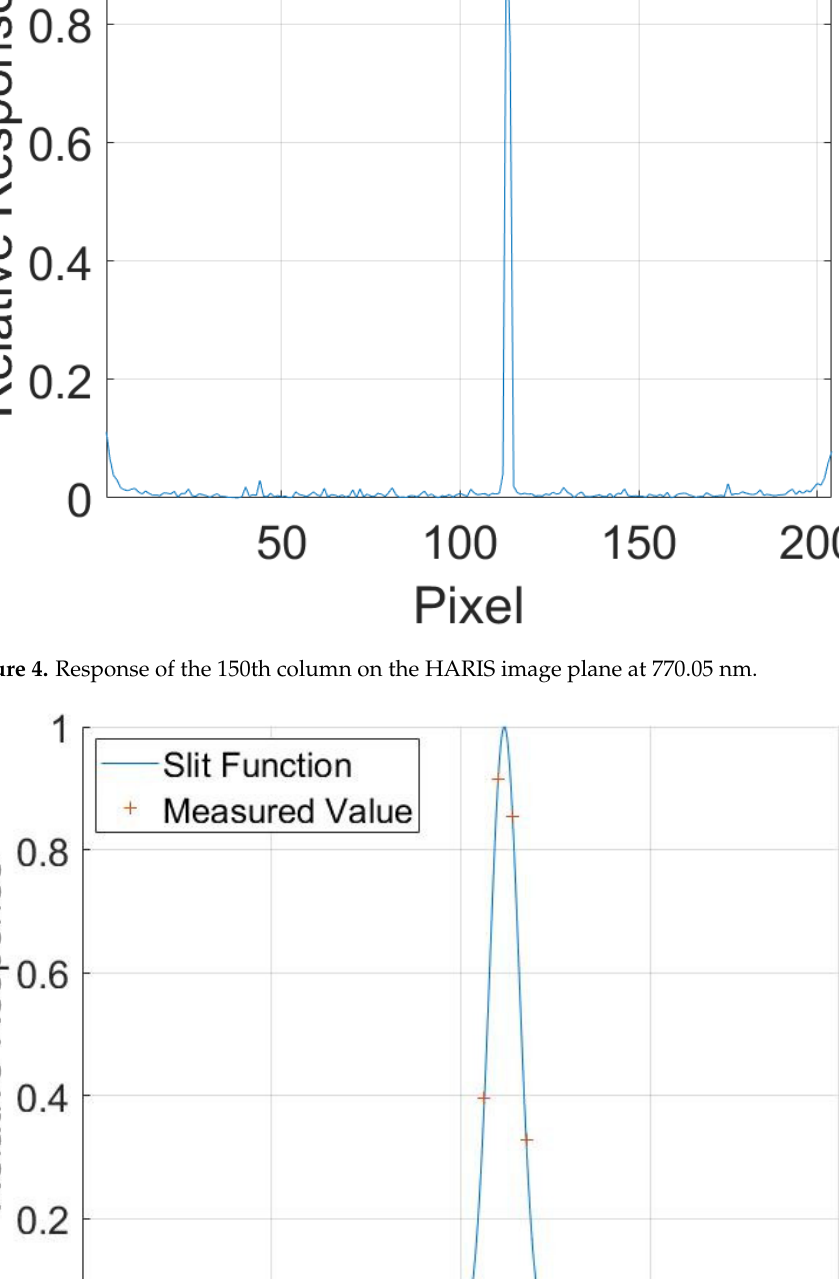
Figure 5. Slit function of the 150th pixel in the 120th row, which corresponds to the central wave- length at 768.46 nm and a FWHM of 0.36 nm.